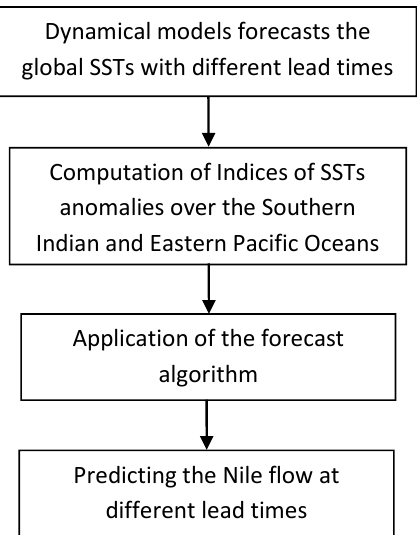
Figure 6. Schematic of the hybrid methodology for predicting the Nile flow using the SST forecasts of the dynamical models and the proposed forecast